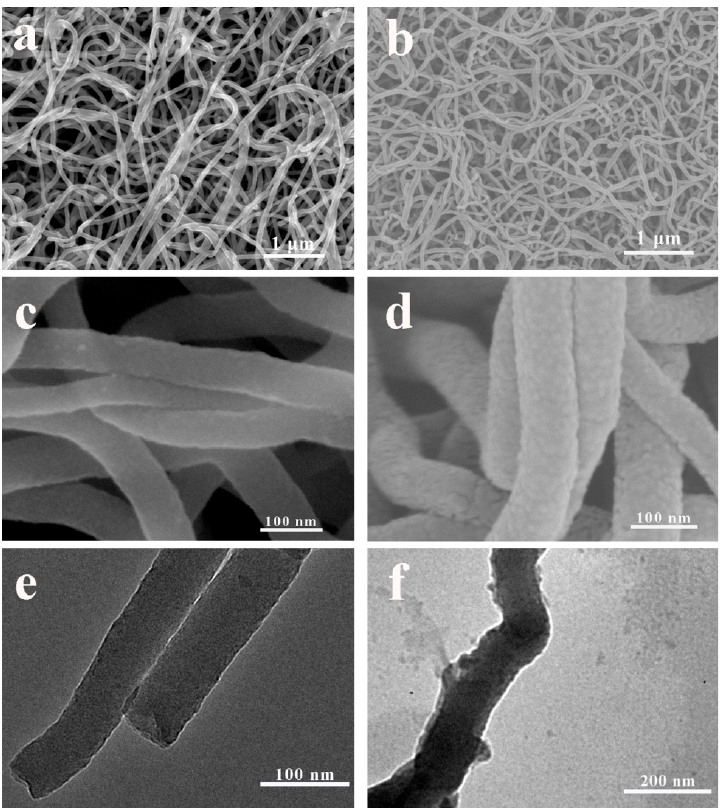
Figure 2. SEM images of PPy NWs ( a ) and PPy/PDA NWs ( b ). High resolution SEM images of PPy NWs ( c ) and PPy/PDA NWs ( d ). TEM images of PPy NWs ( e ) and PPy/PDA NWs ( f ).